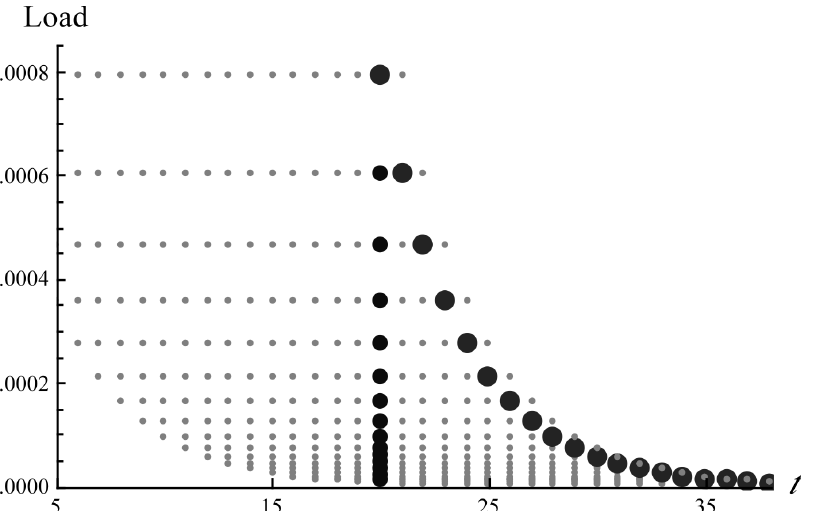
Figure 7. Migration load at the migration-selection balance. The reduction in mean population fitness caused by the descendants of the migrants arrived in the generation 20 is measured every generation that follows (large black dots); this is equivalent to the load caused by the progeny of the migrants arrived in all preceding generations, calculated at point t =20 (smaller black dots). The mean population fitness at any time can therefore be calculated from the branching process within a single lineage, according to Eq